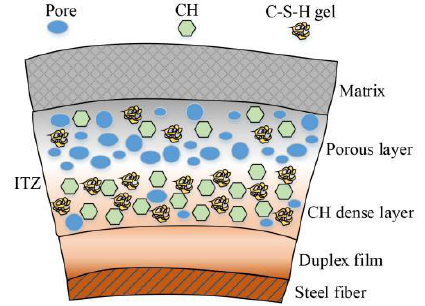
Figure 2. Interface transition zone of SFRRC.